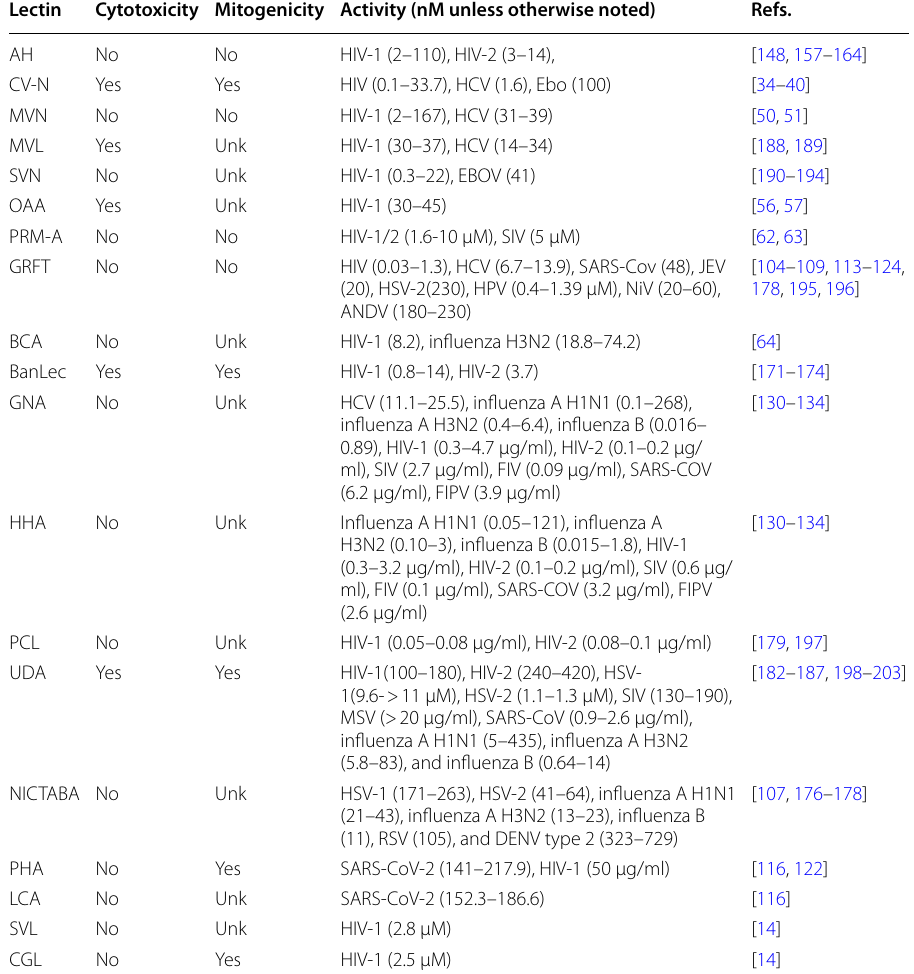
HIV human immunodeficiency virus, HCV hepatitis C virus, EBOV Ebola virus, SIV simian immunodeficiency virus, SARS-CoV severe acute respiratory syndrome coronavirus, JEV Japanese encephalitis virus, HSV herpes simplex virus, HPV human papillomavirus, NiV Nipah virus, ANDV Andes orthohantavirus, FIV feline immunodeficiency virus, FIPV feline infectious peritonitis virus, MSV maize streak virus, RSV respiratory syncytial virus, DENV dengue virus